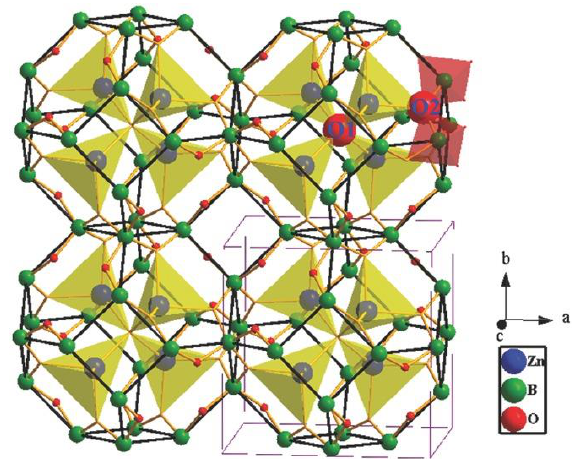
Figure 14. The crystal structure of Zn 4 B 6 O 13 . The neighboring boron atoms are connected by thick black lines to explicitly display the sodalite cages. Reprinted from Ref. [67], with permission of John Wiley and Sons.